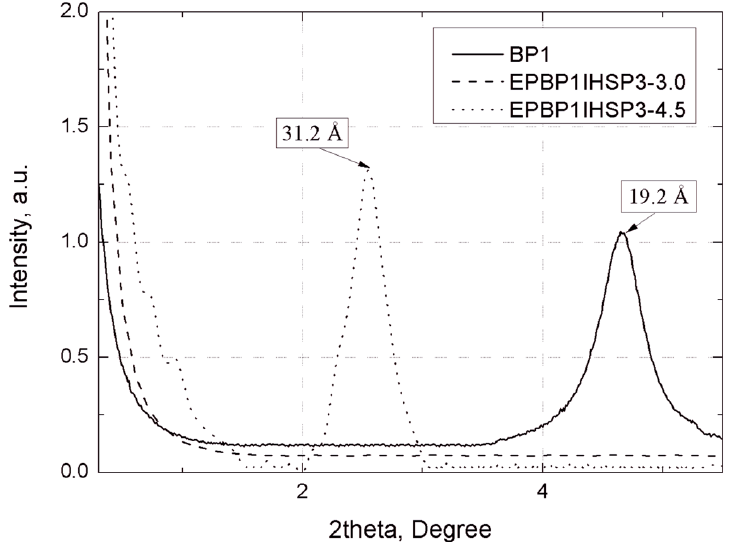
Figure 14. WAXS curves of BP1 and the composites EPBP1K-3.0 and EPBP1K-4.5.